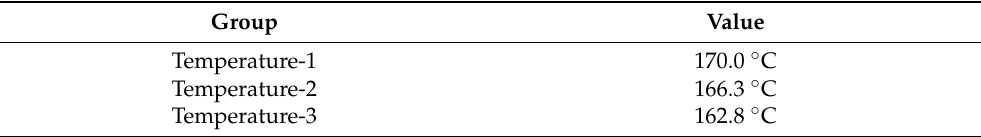
Table 5. Defined temperatures for rheological investigations.